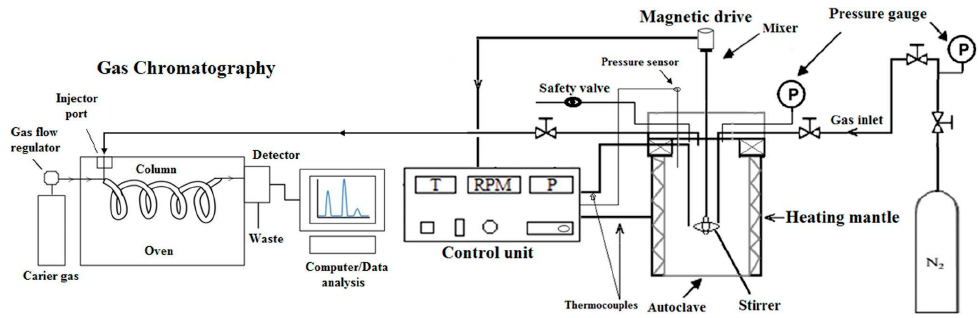
Figure 2. The schematic illustration of the HP/HT